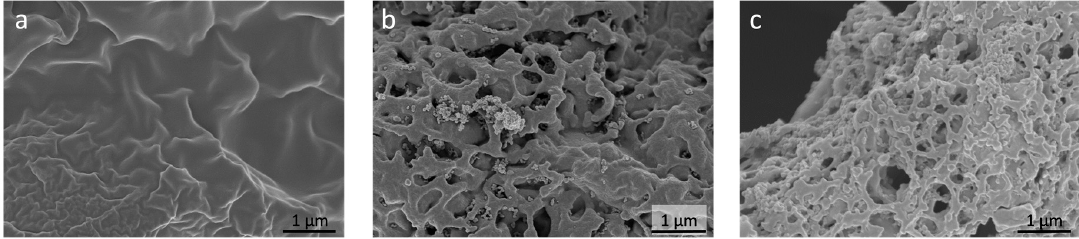
Figure 4. SEM images of ( a ) coffee sludge (CS), ( b ) non-activated hydrochar (HC), and ( c ) activated hydrochar (AHC).